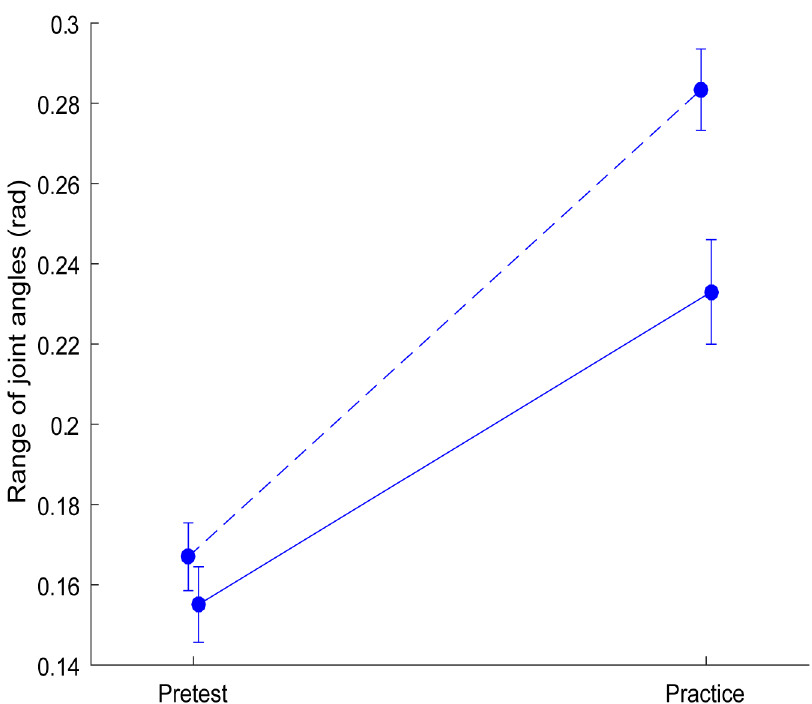
Fig 2. Range of joint angles for each Instant and Condition for the experimental group. The dotted blue line corresponds with Instant at the obstacleand the solid blue line correspondswith Instant at the end of the movement. The pretest is presented on the left and practice on the right. The error bars displaythe standard error of the mean.